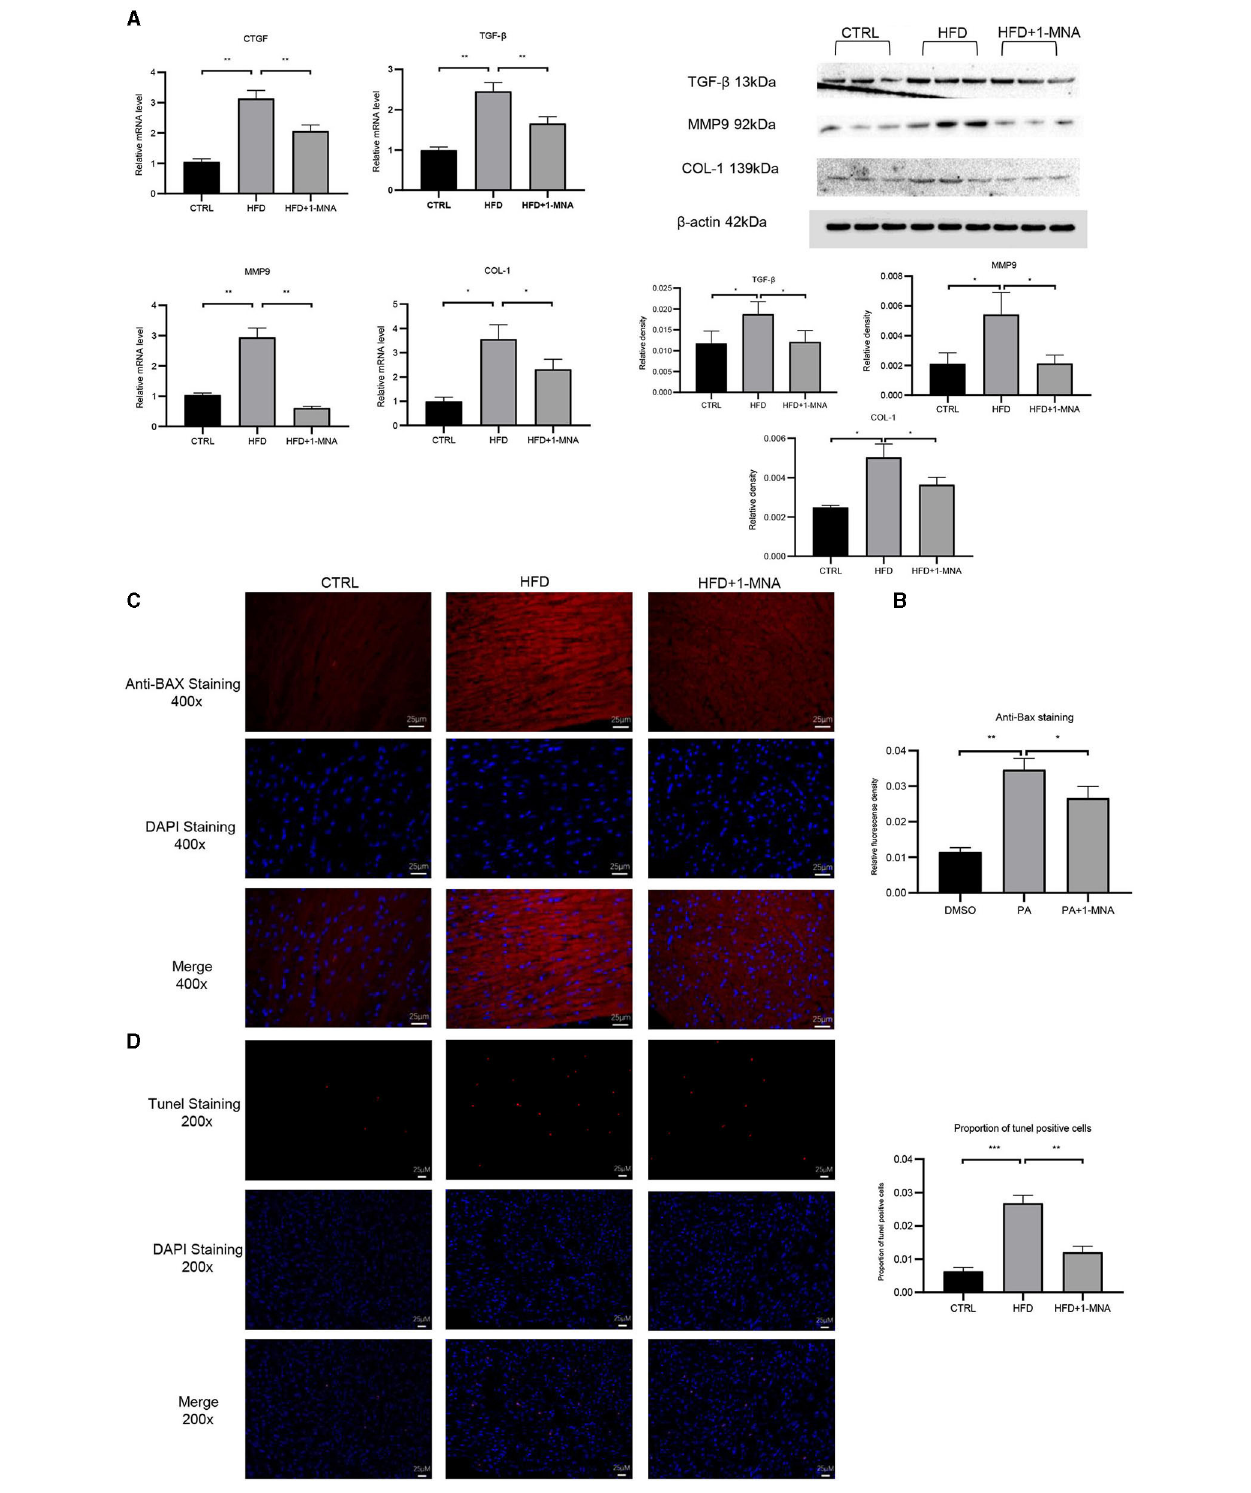
FIGURE 8 | 1-MNA administration improved the fibrosis and apoptosis of the heart induced by HFD. (A) Heart tissues from each group were individually processed for RNA extraction and qRT-PCR analysis. (B) Western blotting analysis of TGF- β , MMP9, and COL-1.1-MNA administration inhibited HFD-induced cardiomyocyte apoptosis. Images of cardiac tissue sections subject to immunohistochemical staining for Bax. (C) The histogram shows the relative fluorescence density of anti-Bax staining. (D) Images of cardiac tissue sections subject to immunohistochemical staining for Tunel. ( n = 5, * P < 0.05, ** P < 0.01, *** P < 0.001).